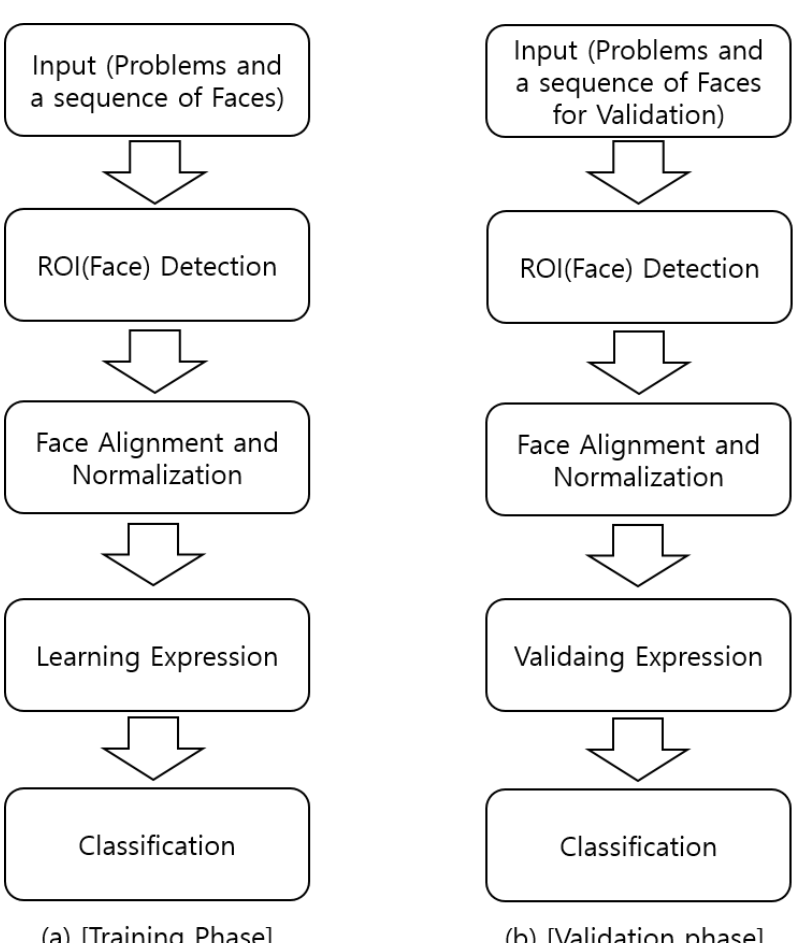
Figure 1. Overall flow of the proposed approach for process-focused assessment (PFA) using recorded face images. The input for this system is a sequence of face images and problems categorized into three classes: easy, neutral, and difficult. ( a ) Training phase to learn facial expressions using a sequence of 2D images that are recorded in real time. ( b ) Validation phase to test and apply the proposed approach on face